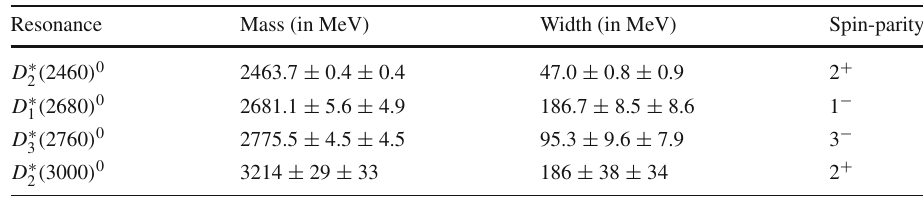
observed from the LHCb analysis of inclusive D ( ∗ ) π production [2]